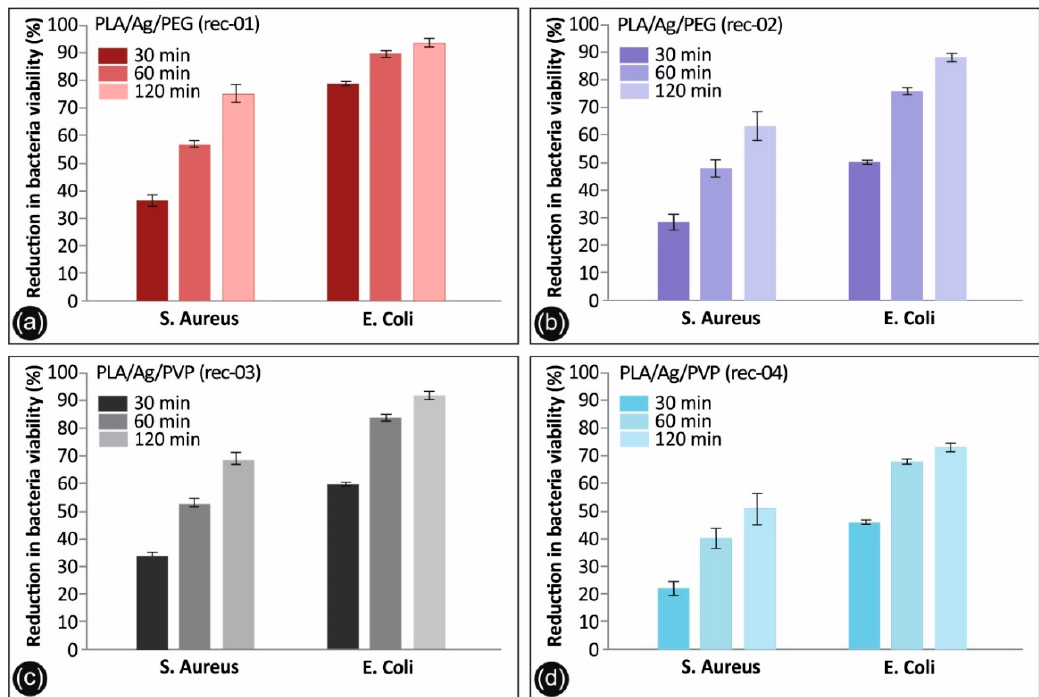
Figure 9. Antibacterial activity of ( a ) PLA/Ag/PEG (rec-01), ( b ) PLA/Ag/PEG (rec-02), ( c ) PLA/Ag/PVP (rec-03) and ( d ) PLA/Ag/PVP (rec-04) 3D printed PLA/AgNP nanocomposites with 100 µm 3D printed layer thickness, against S. aureus and E. coli after 30, 60, and 120 min of contact. Mean values do not differ significantly ( p < 0.05). Biomimetics 2020 , 5 , x FOR PEER REVIEW